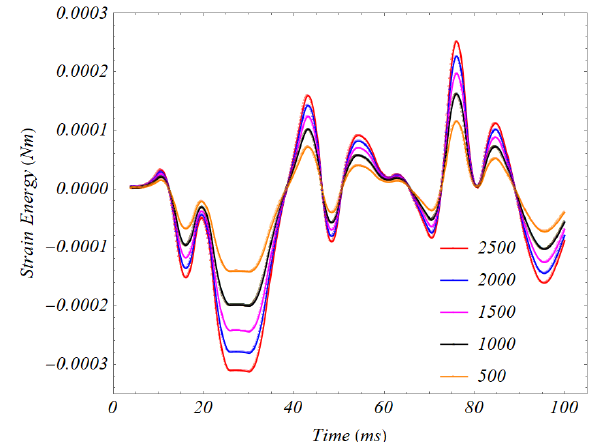
Fig. 12. Strain energy against time for various drop distances with four cellphone casing